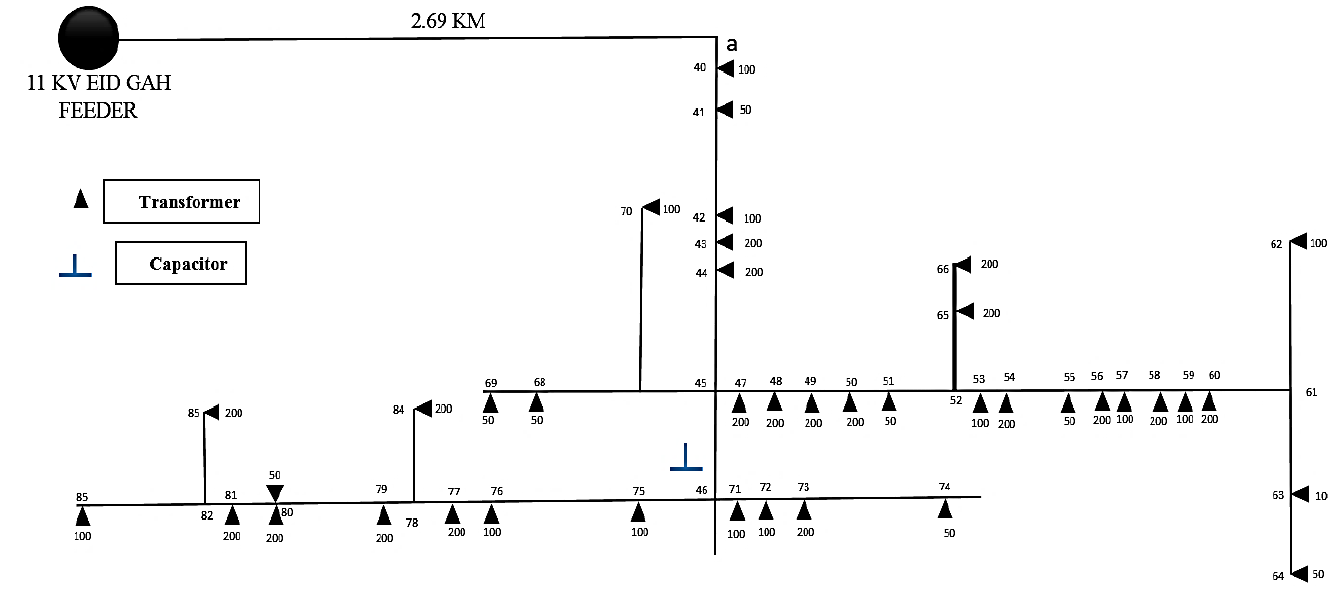
Fig. 4. Proposed (F2) line diagram of EidGah feeder